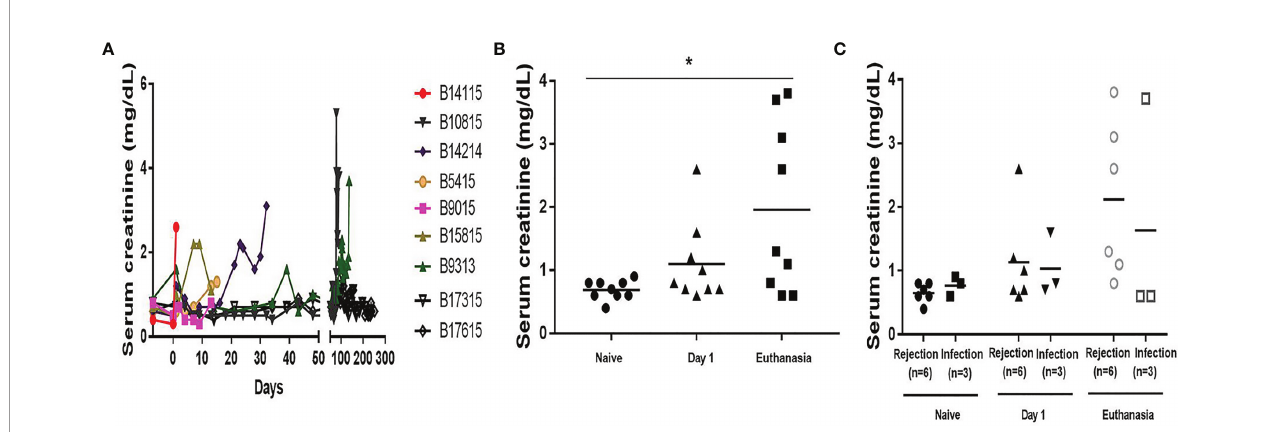
FIGURE 1 | Serum creatinine in baboons with pig kidney grafts. (A) Levels of serum creatinine in the baboons (n=9) at different time-points. (B) The difference of the levels of serum creatinine in the baboons (n=9) at pre-Tx (naïve), day 1 after operation, and at euthanasia. (C) The differences in serum creatinine between the rejection (n=6) and infection (n=3) groups at pre-Tx (naïve), day 1 after operation, and at euthanasia. (*p < 0.05).